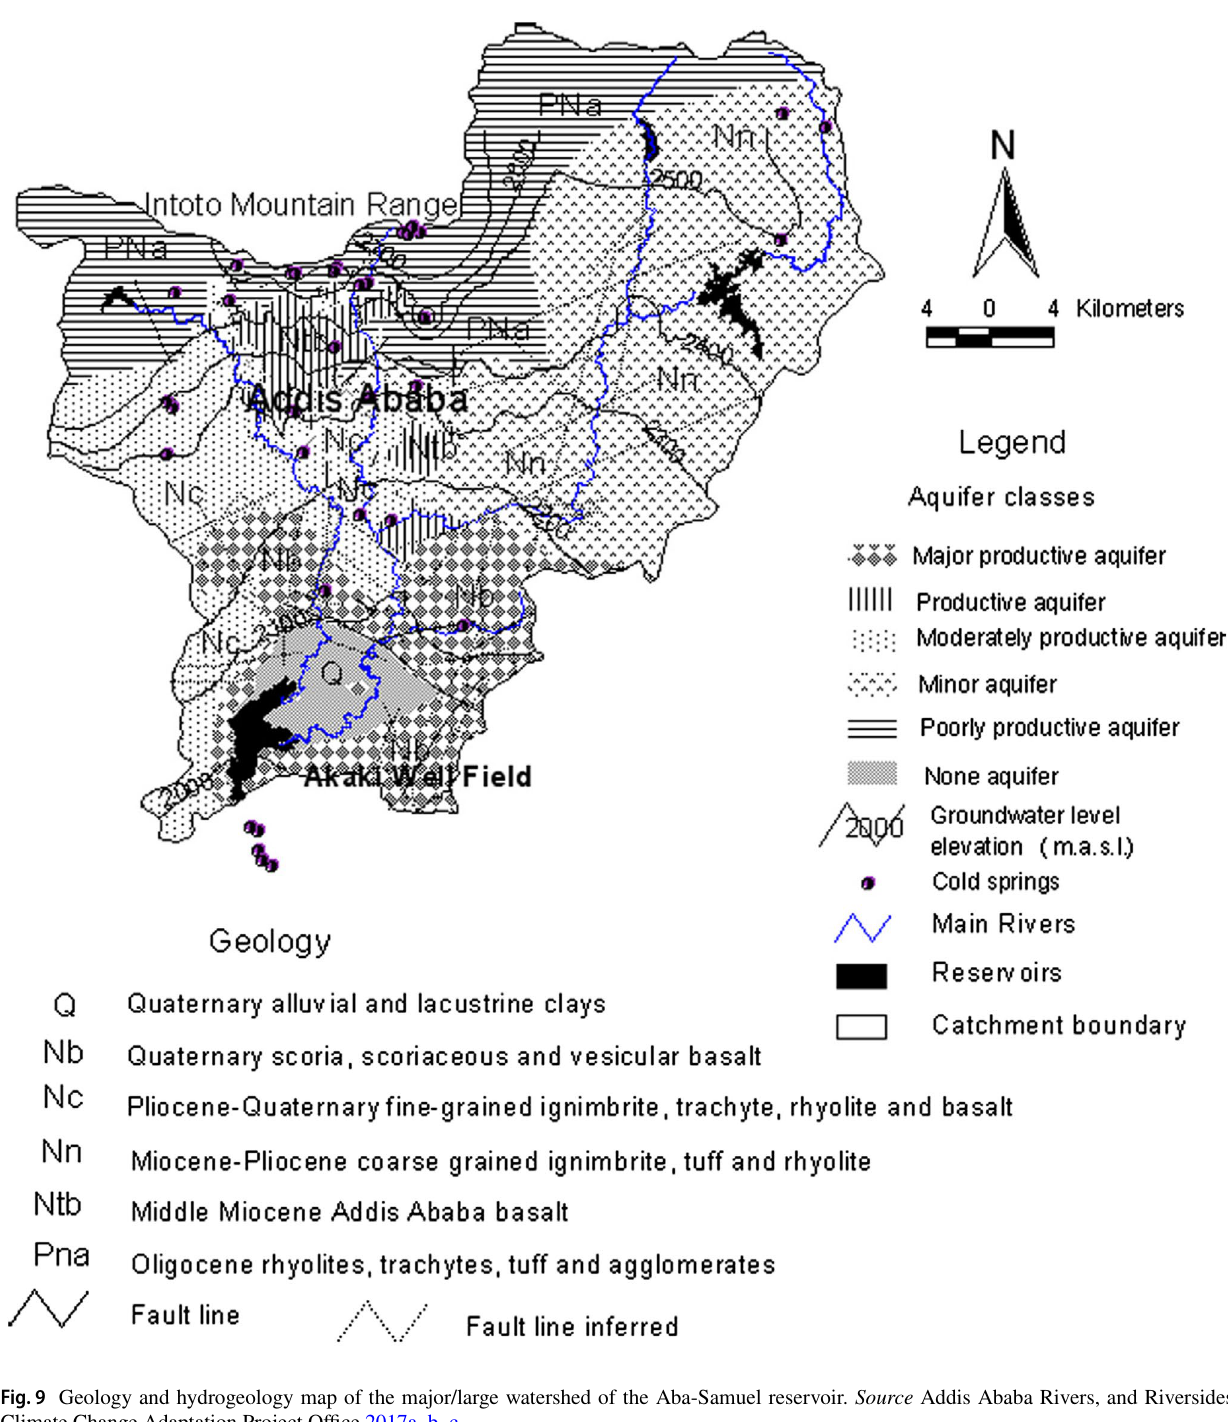
Fig. 9 Geology and hydrogeology map of the major/large watershed of the Aba-Samuel reservoir. Source Addis Ababa Rivers, and